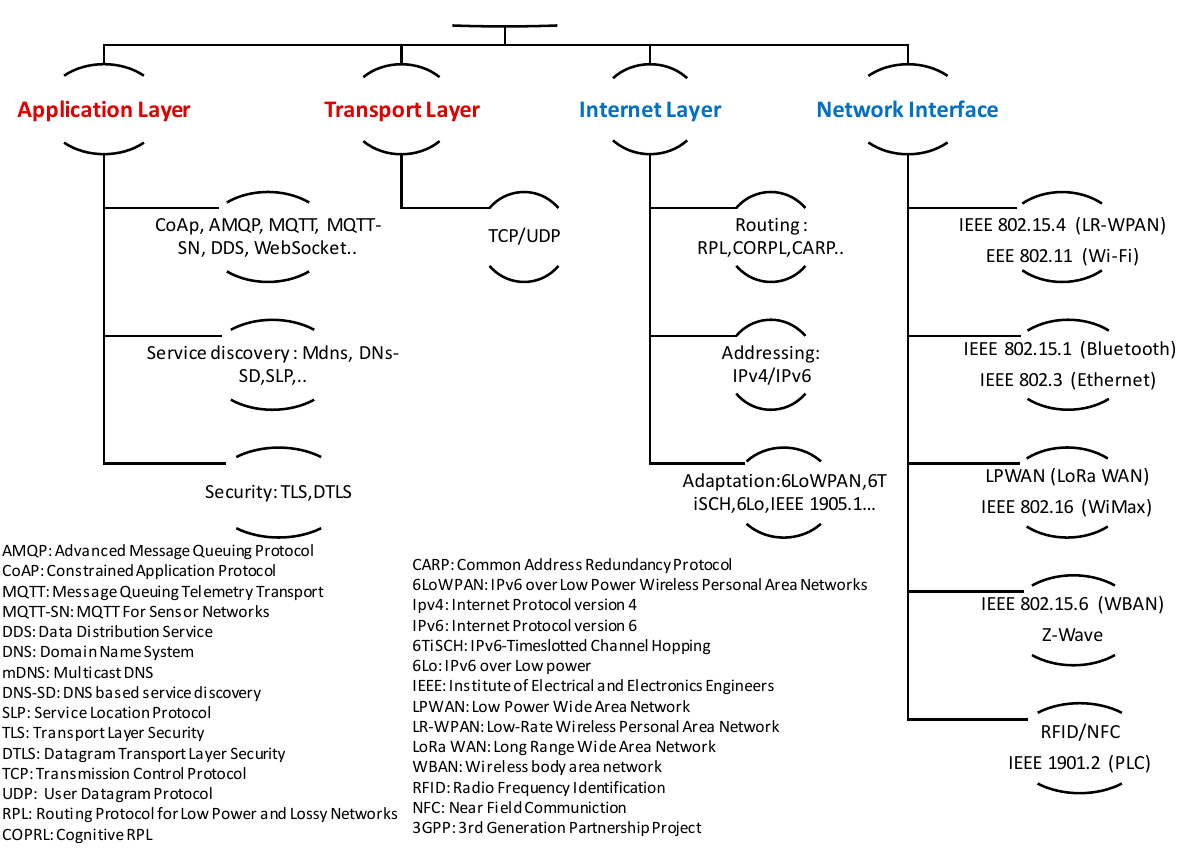
Figure 2. Summary of most prevalent protocols according to the levels of IoT architecture.